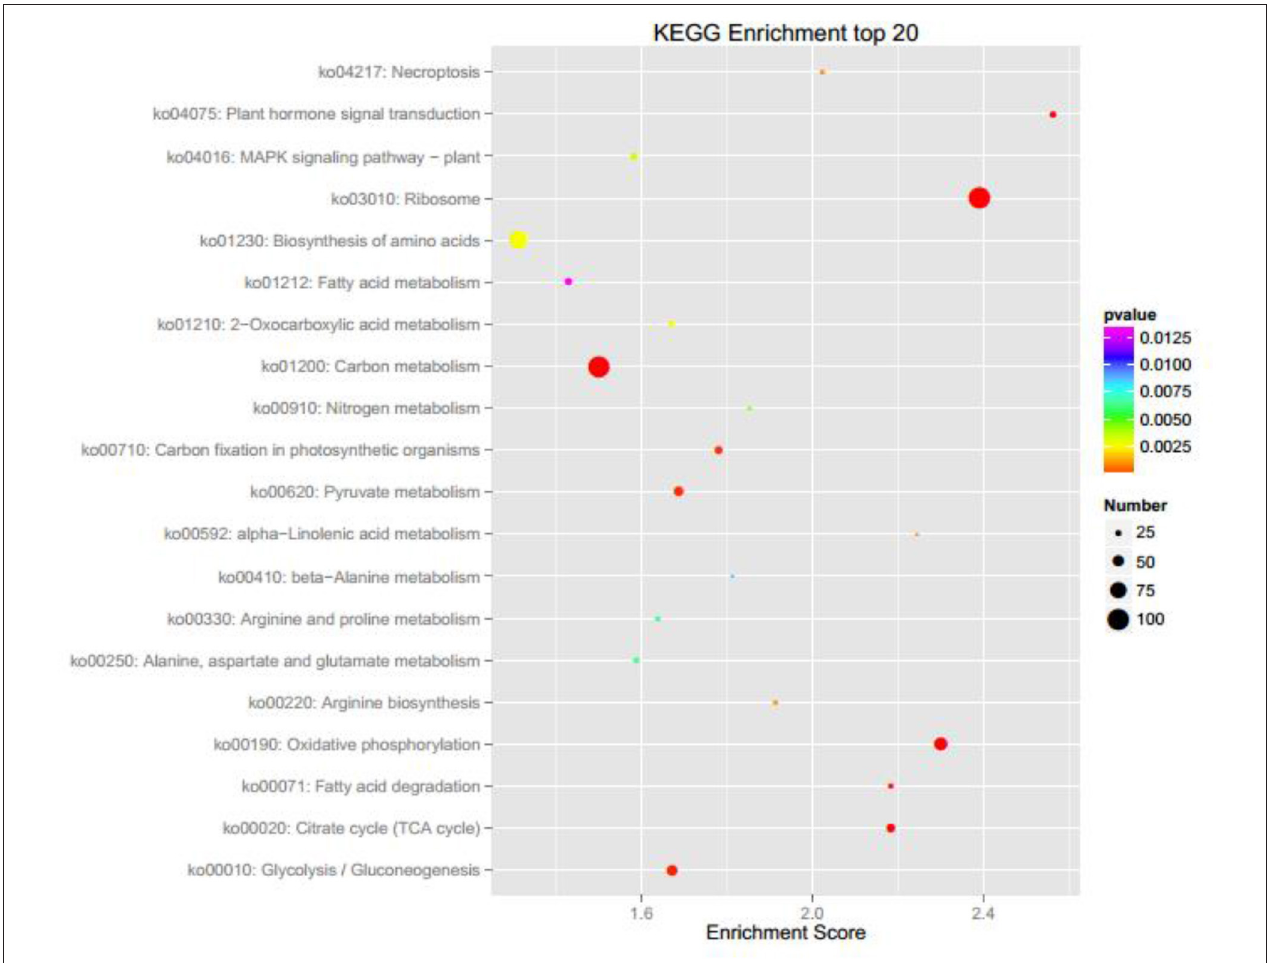
FIGURE 2 | The KEGG enrichment top 20 of wild type N. oceanica and the